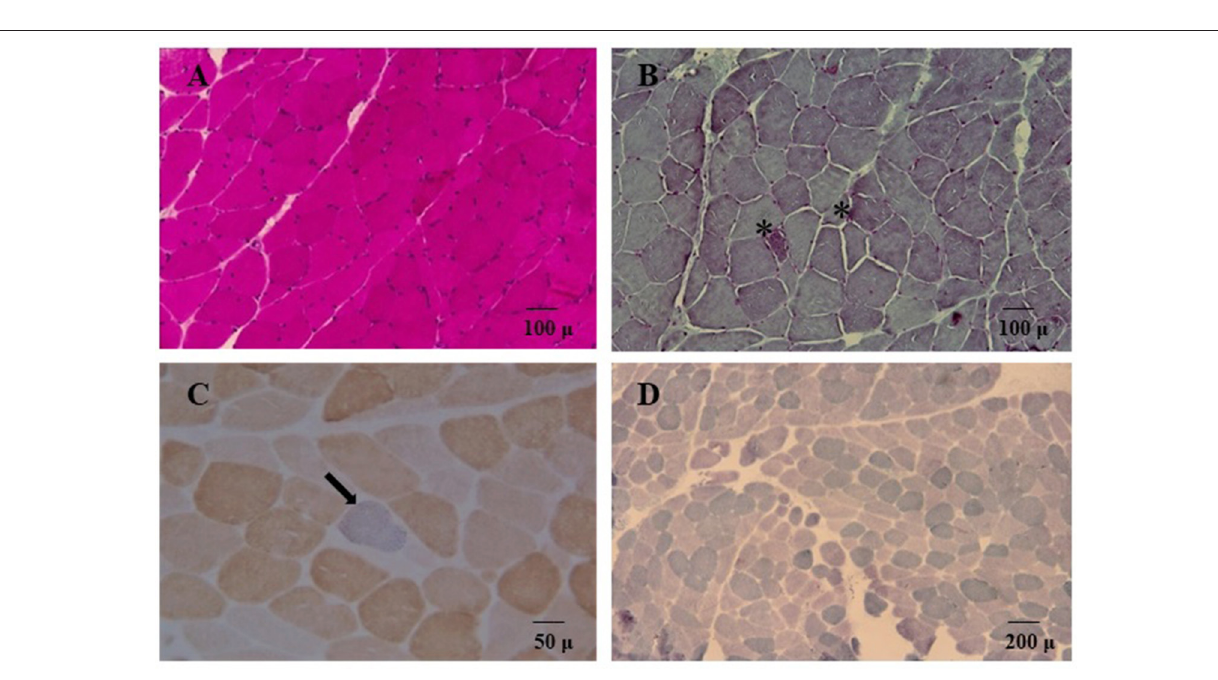
rare predictably pathogenic variants of clinical